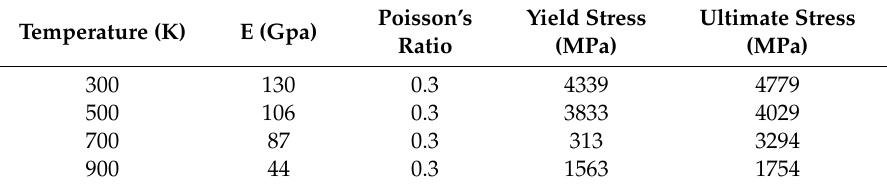
Table 5. Mechanical properties of the copper alloy (CuCrZr).